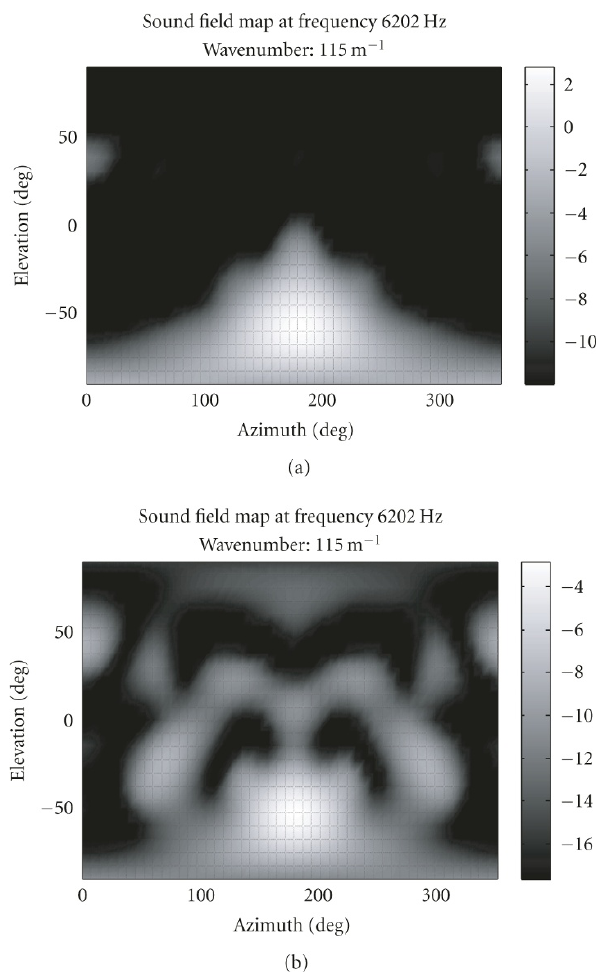
Figure 11: Sound field cartographies for a point source located at [ r = 1m, az = 180dg, el = − 58dg], at frequency 6202 Hz, using omnidirectional (a) or cardioid (b)